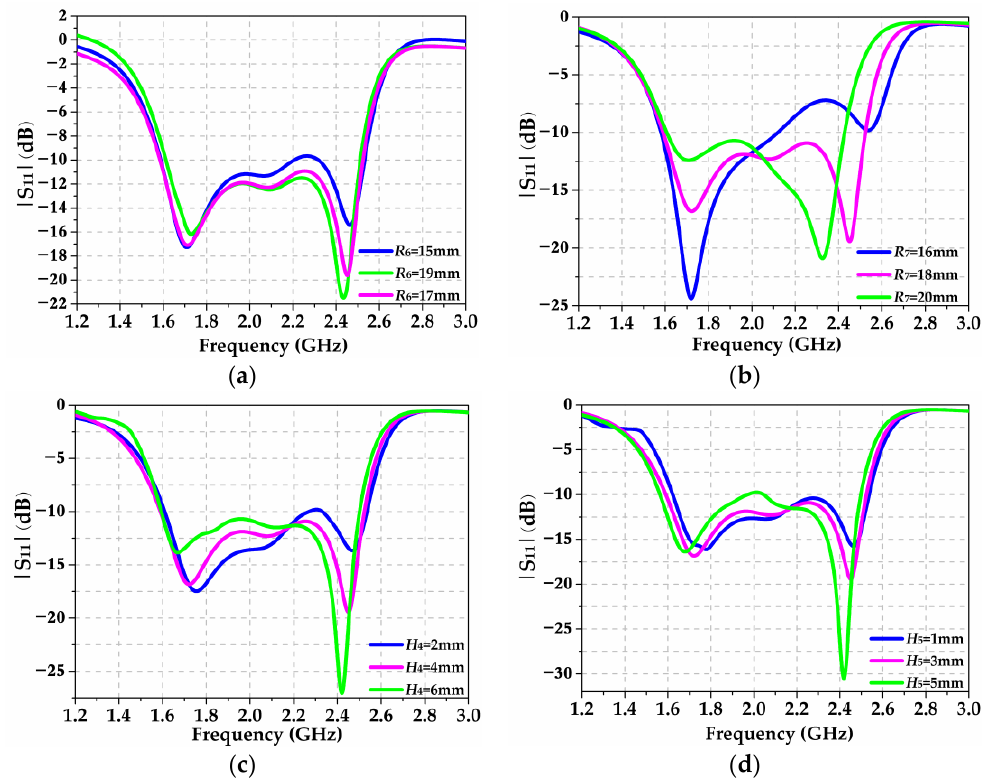
Figure 11. Parameter studies of the step cylinder: ( a ) R 6 ; ( b ) R 7 ; ( c ) H 4 ; ( d ) H 5 .